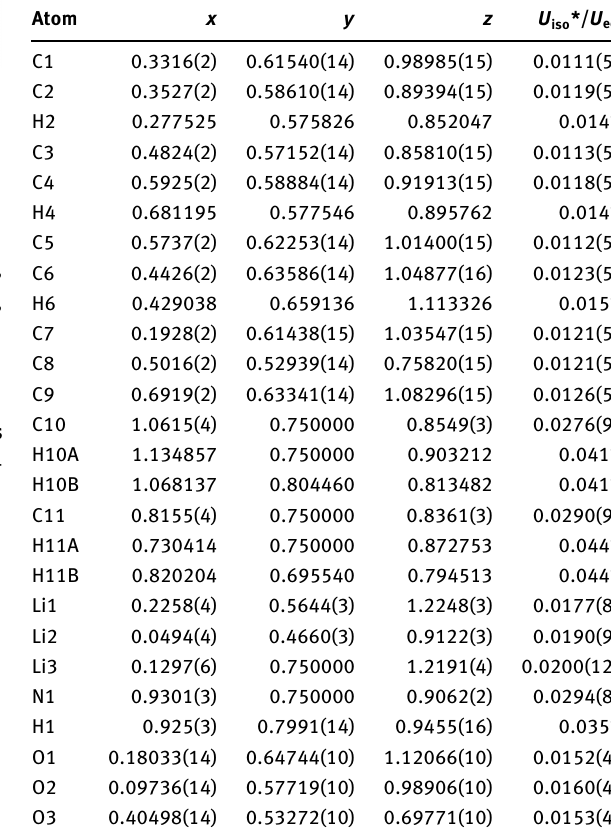
Table 2: Fractional atomic coordinates and isotropic or equivalent isotropic displacement parameters (Å 2